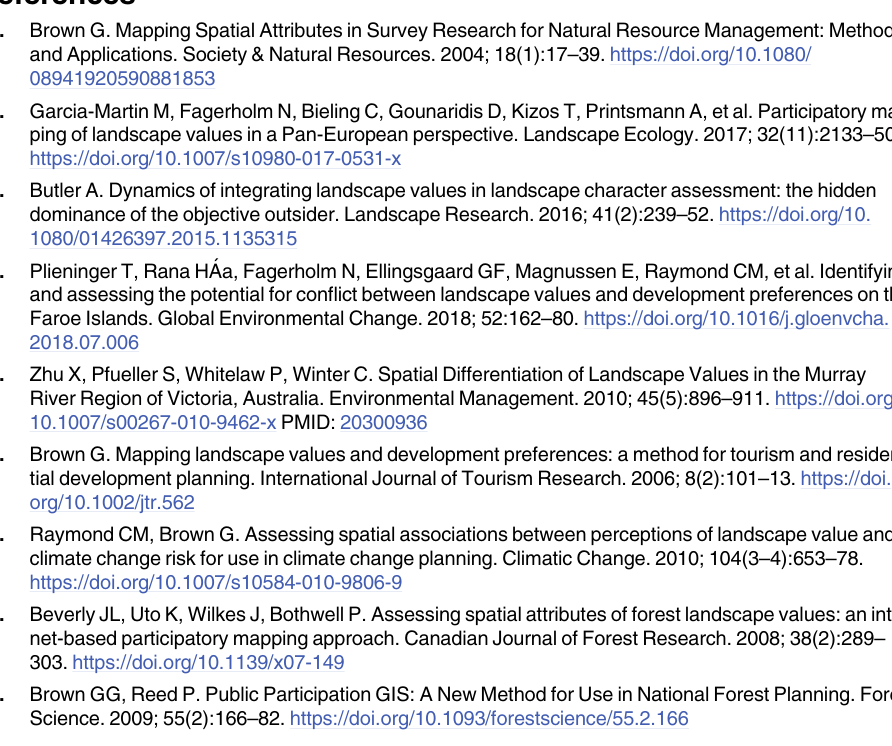
(Landsat 8) are used from USGS Earth Explorer (public domain) https://earthexplorer.usgs. gov; and point data is established by the authors. S4 File. Mapping data for Fig 5. Fig 5: Administration data is used from Diva-GIS project (public domain) https://www.diva-gis.org/Data; Digital Elevation Model is used from USGS Earth Explorer (public domain)